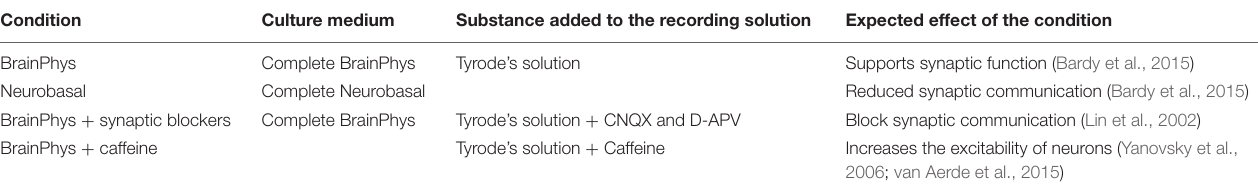
TABLE 1 | Summary of the conditions